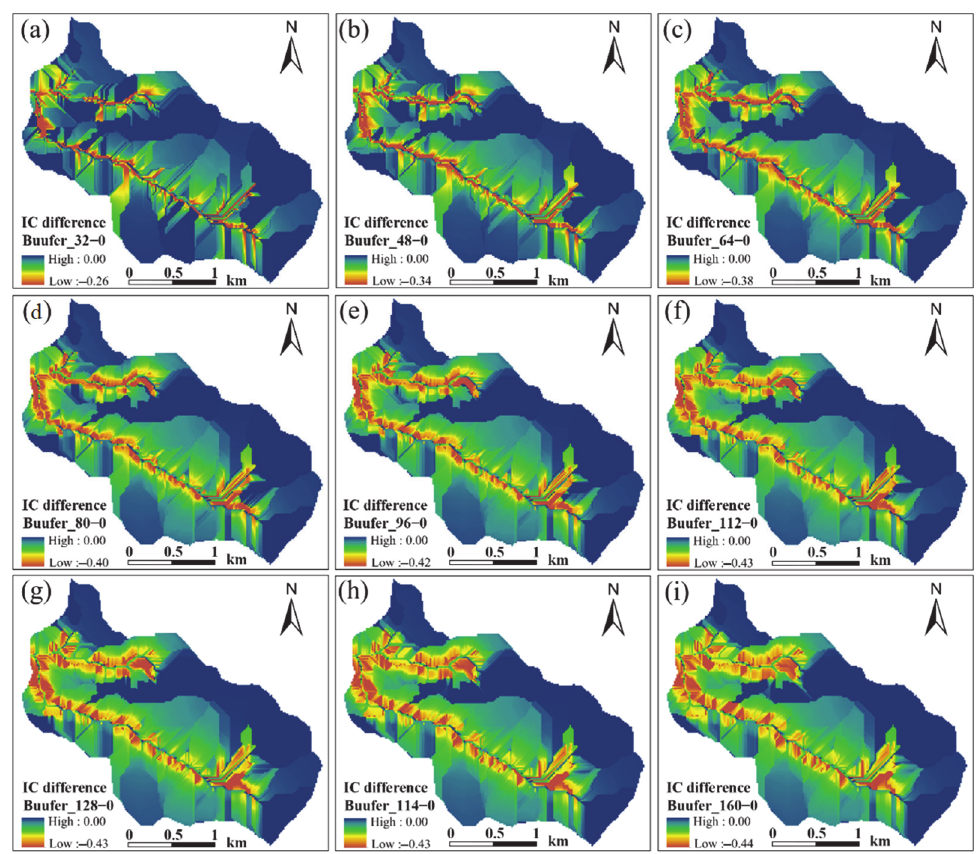
Figure 9. Difference in effect of riparian buffer scenarios (buffer_32 ( a ), buffer_48 ( b ) buffer 64 ( c ), buffer 80 ( d ), buffer_96 ( e ), buffer_112 ( f ), buffer_128 ( g ), buffer_144 ( h ), and buffer_160 ( i )) and absence of buffer on sediment connectivity.